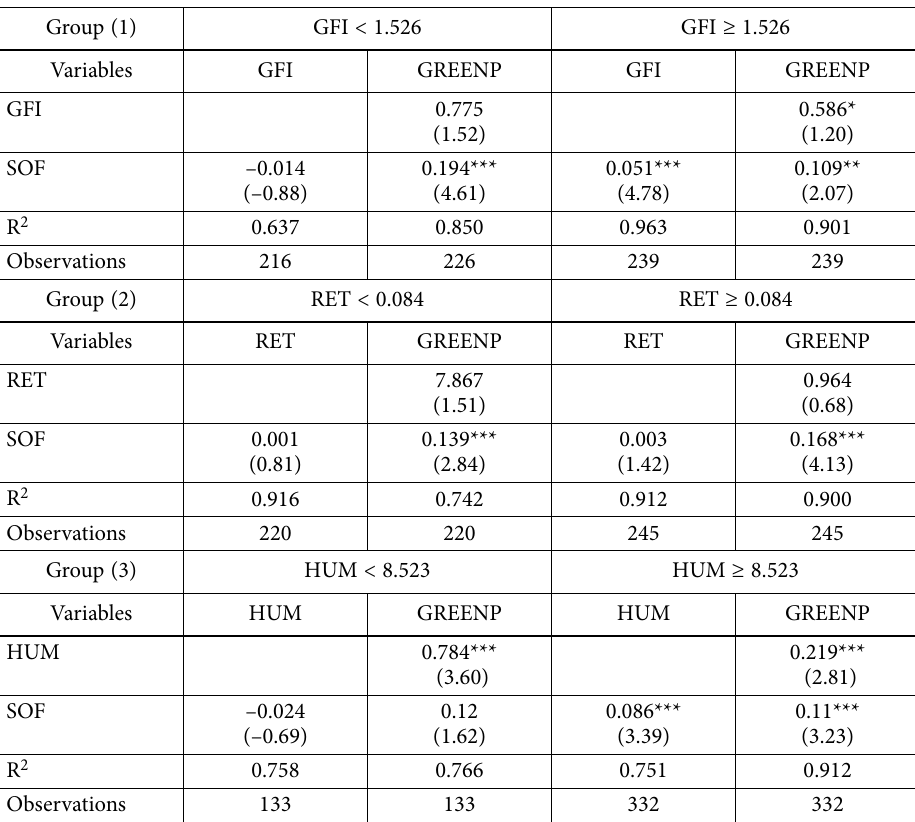
Table 9. Estimation for the mediating threshold regression